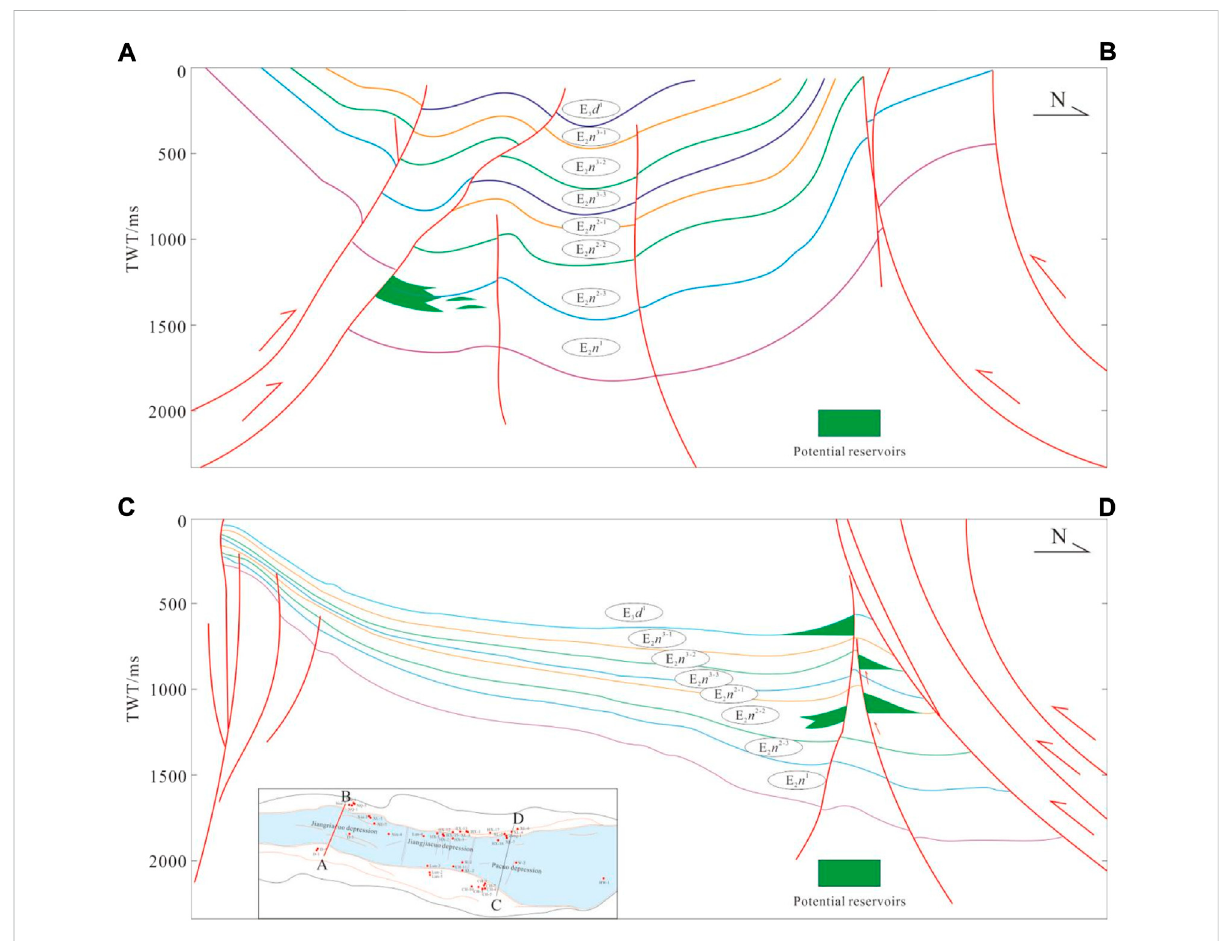
FIGURE 5 Prediction diagram of hydrocarbon accumulation pattern in Lunpola